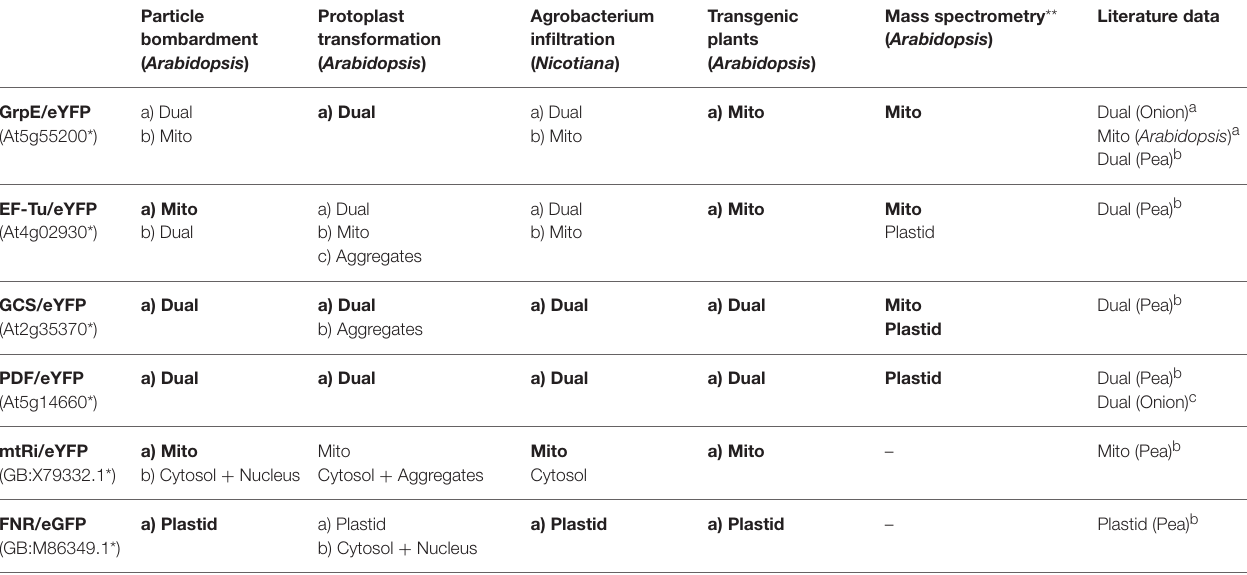
TABLE 1 | Localization of candidate proteins obtained with different experimental